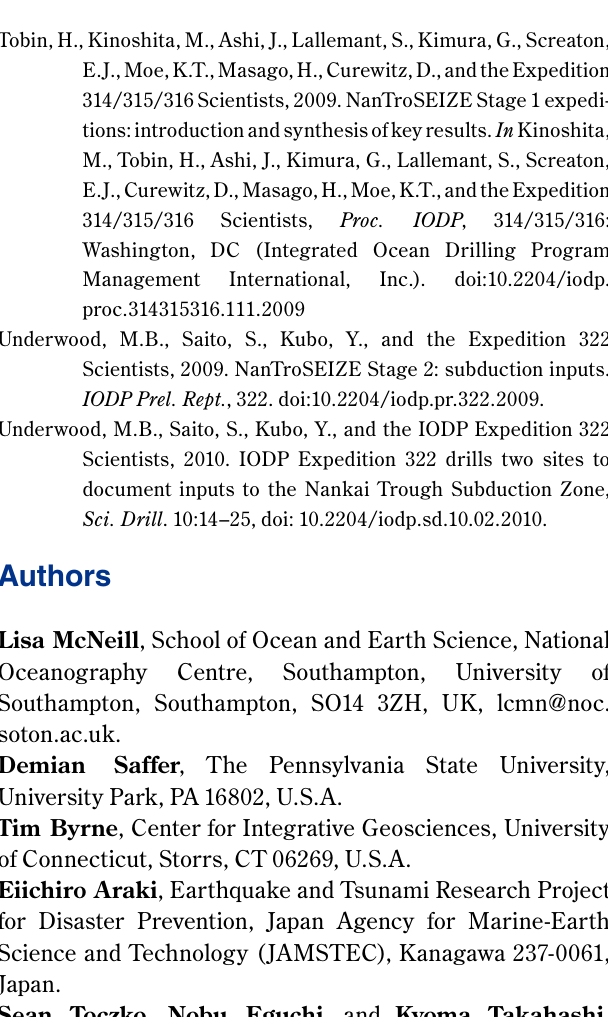
Fig. 3 A. by Lisa McNeill, University of Southhampton Fig.3 B and C. by